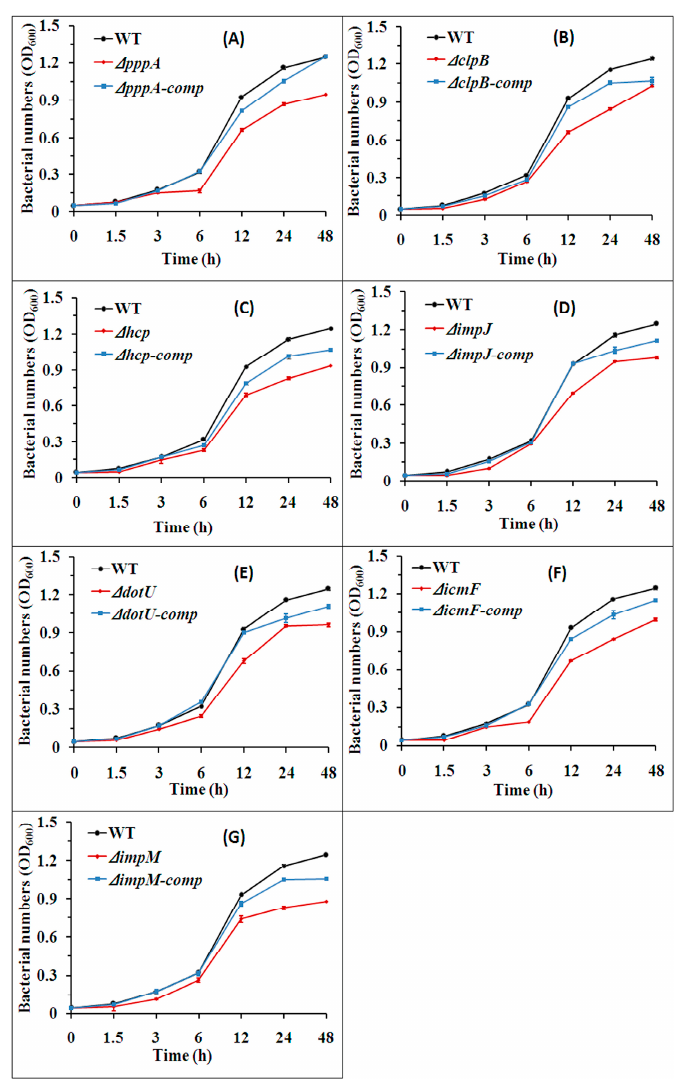
Figure 6. Bacterial growth of the wild-type, the T6SS mutants and their corresponding complemented strains of Acidovorax avenae subsp. avenae strain RS-2. ( A – G ) Indicate the comparisons between wild-type and the mutant/complementation of gene pppA , clpB , hcp , impJ dotU , icmF and impM , respectively. Means ± SEM are shown ( n = 6). The experiment was repeated three times and here is presented one set of representative data.